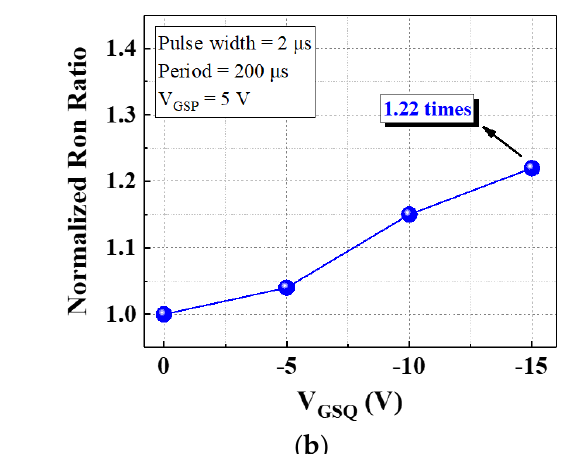
Figure 4. ( a ) Condition of pulse measurement and ( b ) gate lag characteristic.